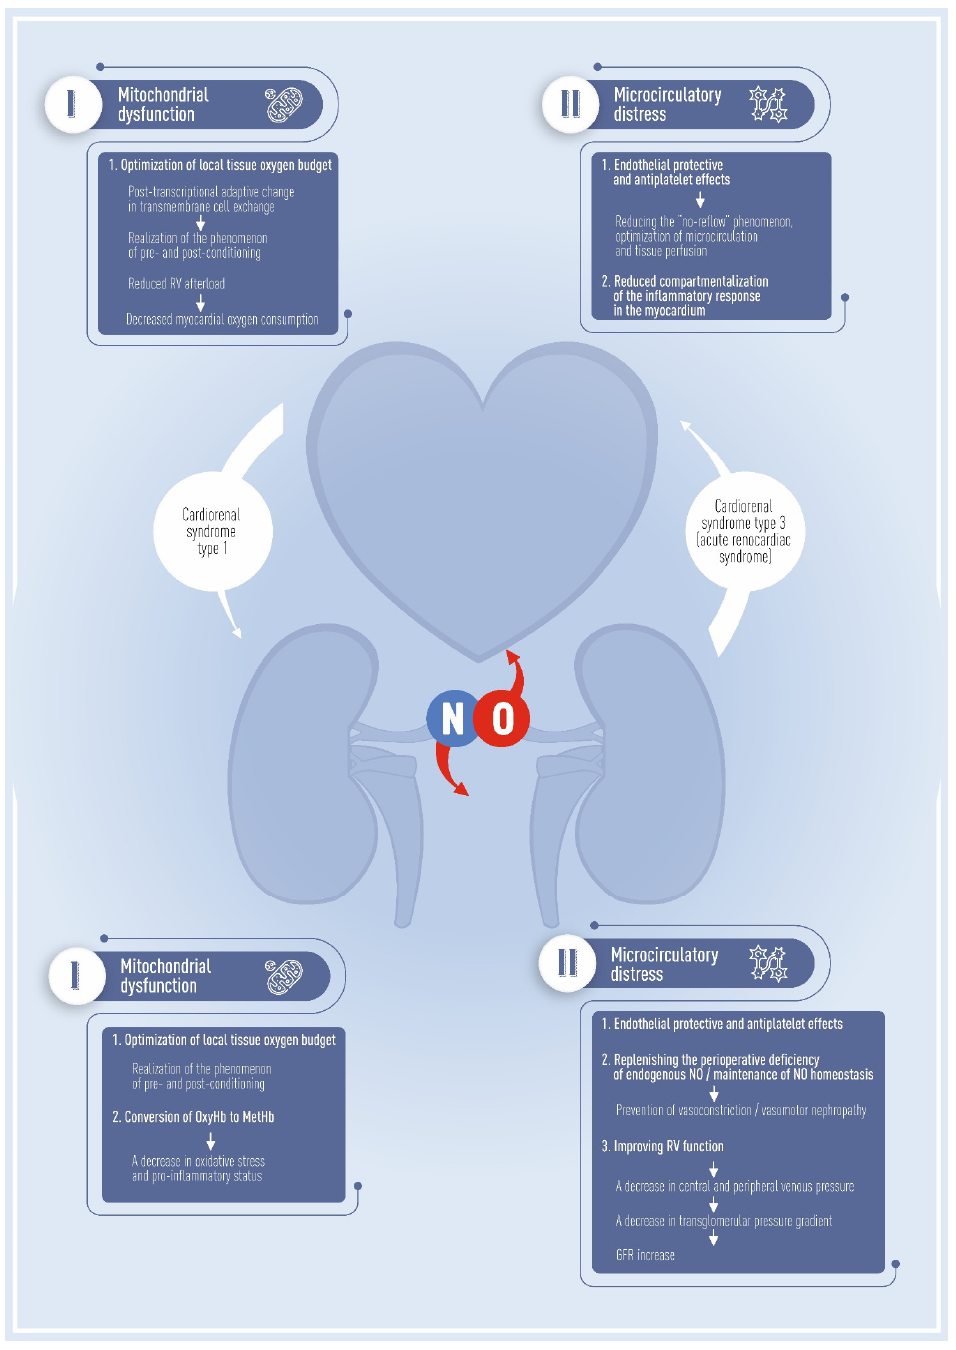
Figure 1. Nitric oxide in perioperative organ protection. The modern paradigm of the pathogenesis of perioperative myocardial and kidney injuries in cardiovascular surgery implies a close relationship of organ complications in the heart–kidney axis. The additive potentiation of multiple organ dysfunction is referred to as the cardiorenal continuum and includes both the direct association of cardiac dysfunction with the development of AKI (cardiorenal syndrome type 1) and reversible myocardial injury in the manifestation of AKI (cardiorenal syndrome type 3-acute renocardiac syndrome). The figure illustrates the fundamental basis for targeted perioperative prevention of organ dysfunction. NO therapy may prevent the cardiorenal continuum in cardiac surgery through a pluripotent positive effect on mitochondrial and microcirculatory distress in the heart–kidney axis. NB: Right ventricle (RV); oxyhemoglobin (OxyHb); methemoglobin (MetHb); glomerular filtration rate